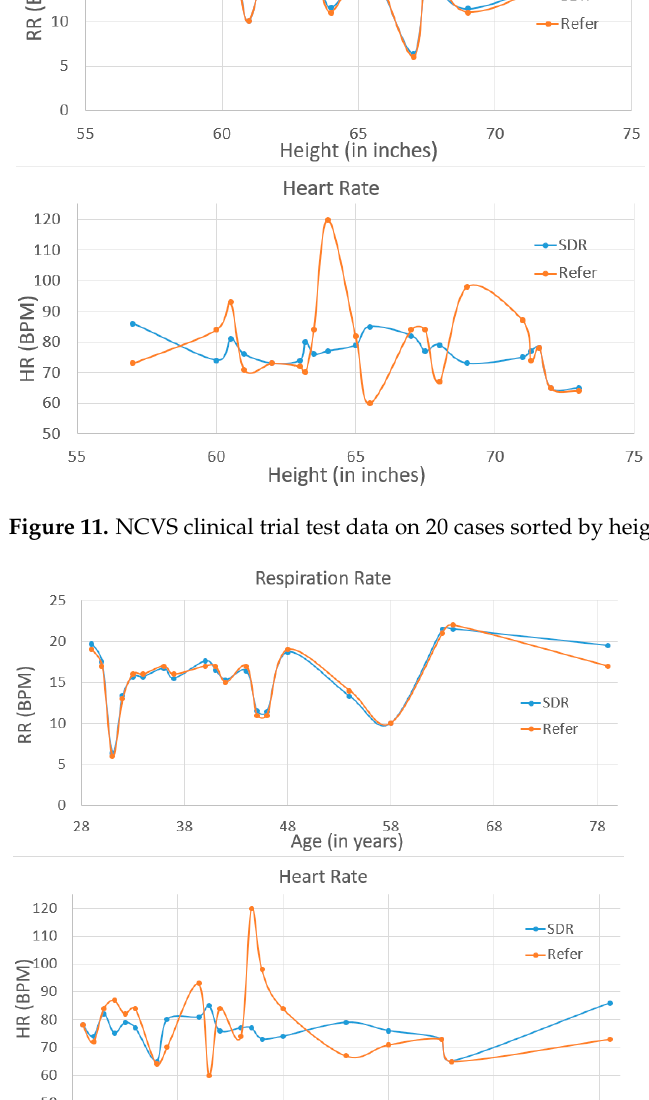
Figure 12. NCVS clinical trial test data from 20 cases sorted by age.